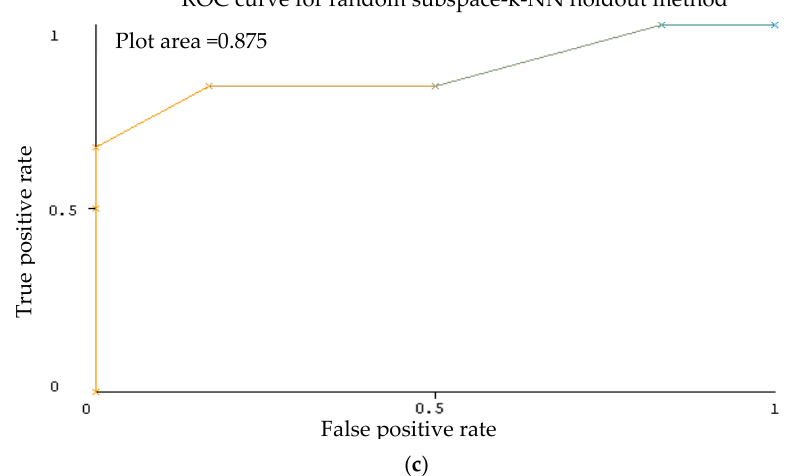
Figure 9. ROC graph activity of ensemble classifier bagging ( a ), Adaboost ( b ), random subspace ( c ) with k-NN classifier using holdout method Dataset 1.